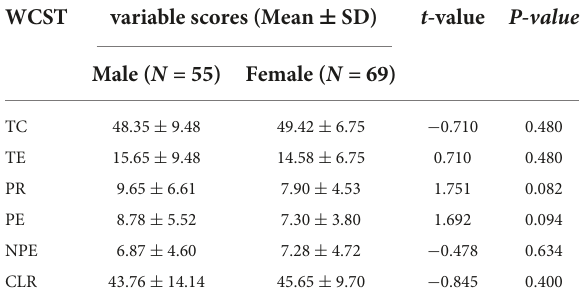
TABLE 4 Comparation of WCST scores between male and female